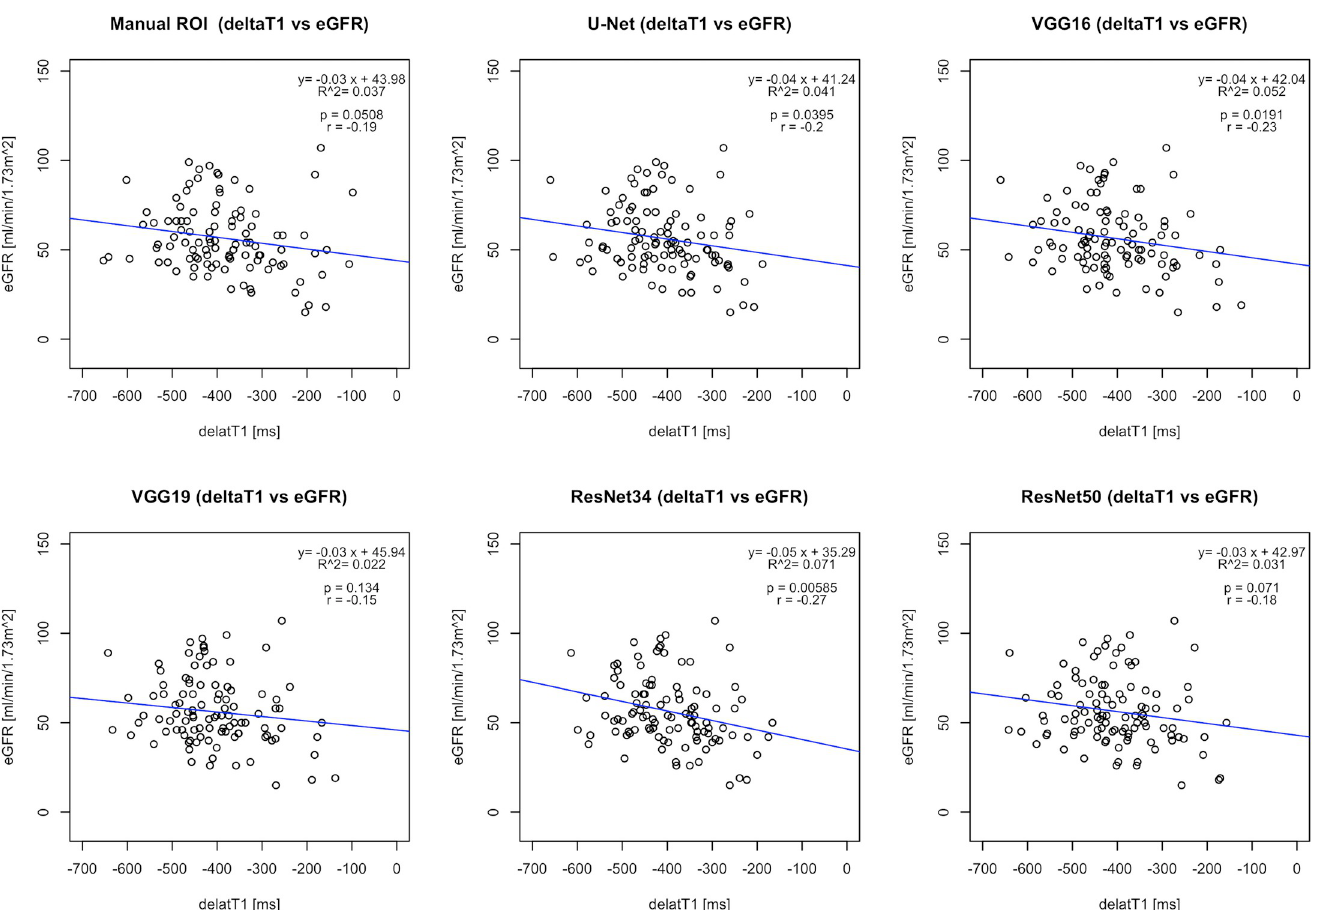
Fig 6. The correlation analysis and scatter plots of gold-standard manual ROIs [4], deep learning-based methods Δ T1 values with eGFR. The correlation results show negative correlation between MRI values and eGFR.